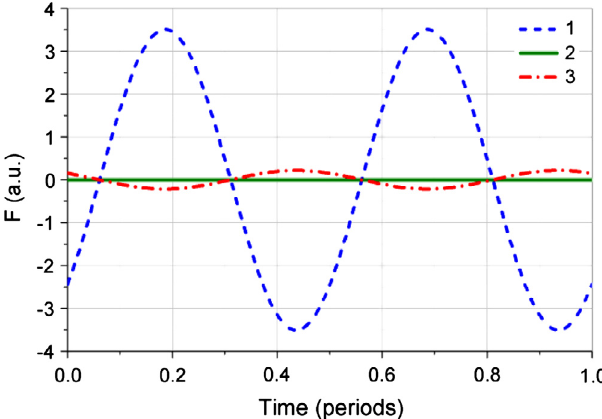
Figure 2. Force acting on chiral particles vs. time: the blue dashed line (no. 1) corresponds to the particle with a ee 5 0, a mm = 0, a em = 0. The red dash-dot line (no. 3) corresponds to the particle with a mm 5 0, a ee = 0, a em = 0. The green solid line (no. 2) represents the particle with a ee = a mm = a em 5